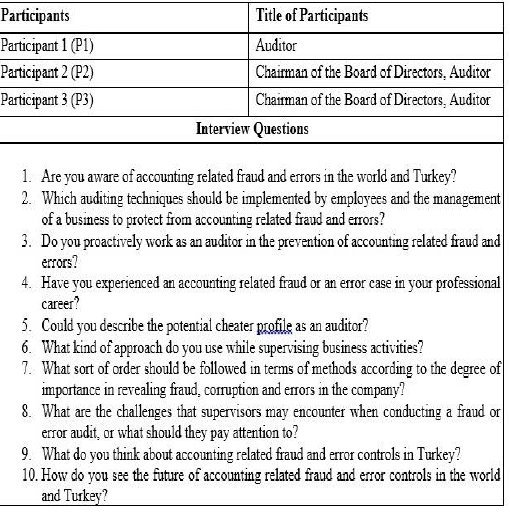
Table 2: Participant Information and Interview